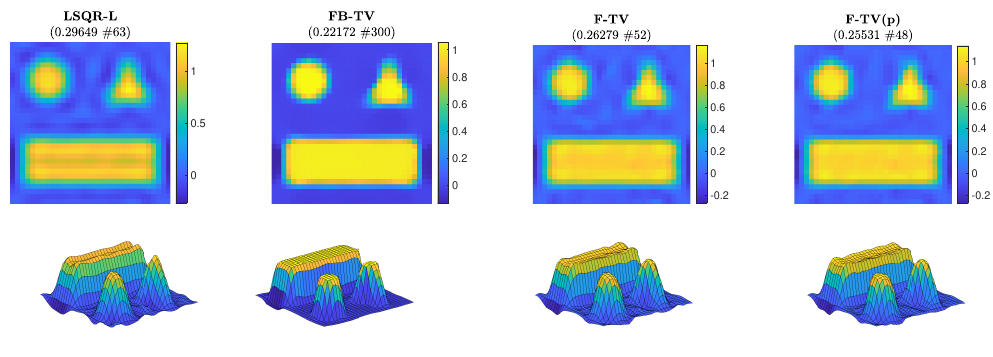
Figure 3. Experiment 1, with N = 32 . Reconstructed solutions from LSQR-L, FBTV, F-TV, and F-TV(p) when the respective stopping criterion has been satisfied. The RRE and corresponding stopping iteration are displayed in the frame